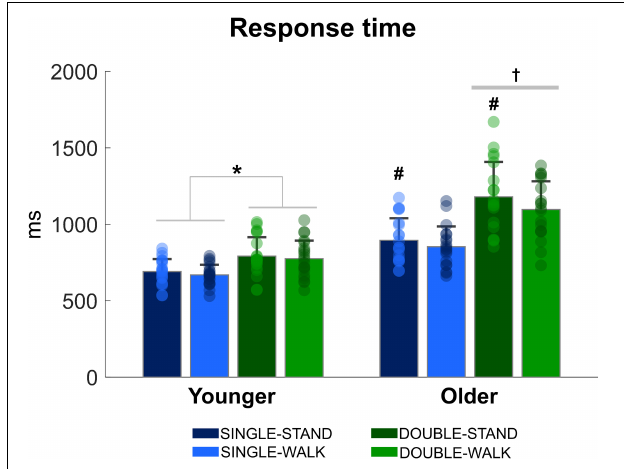
FIGURE 2 | Mean (SD) and individual values of response time in four conditions: single stimulus while standing (SINGLE-STAND), single stimulus while walking (SINGLE-WALK), double stimuli while standing (DOUBLE-STAND), double stimuli while walking (DOUBLE-WALK) for younger and older adults. *Denotes significant difference between SINGLE and DOUBLE stimuli ( p < 0.0001). † Denotes significant difference in relation to single stimuli condition for older adults, and single and double stimuli conditions for young adults ( p < 0.001). # Denotes significant difference in relation to walking conditions for the same group ( p <